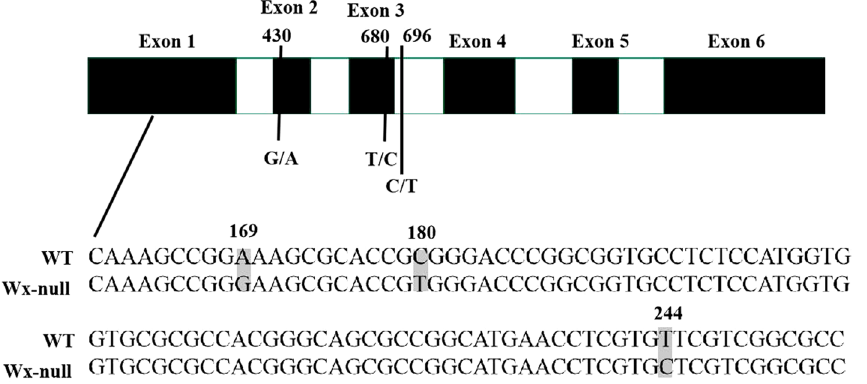
Figure 4. Analysis of Wx-B1 gene sequences in wild-type and Wx-null line. Black and white boxes respectively indicate exons and introns. Numbers show base position. SNPs is indicated by the shaded